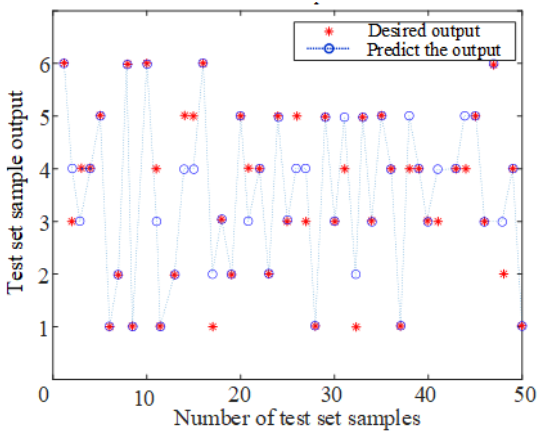
Figure 15. RVFLNS test